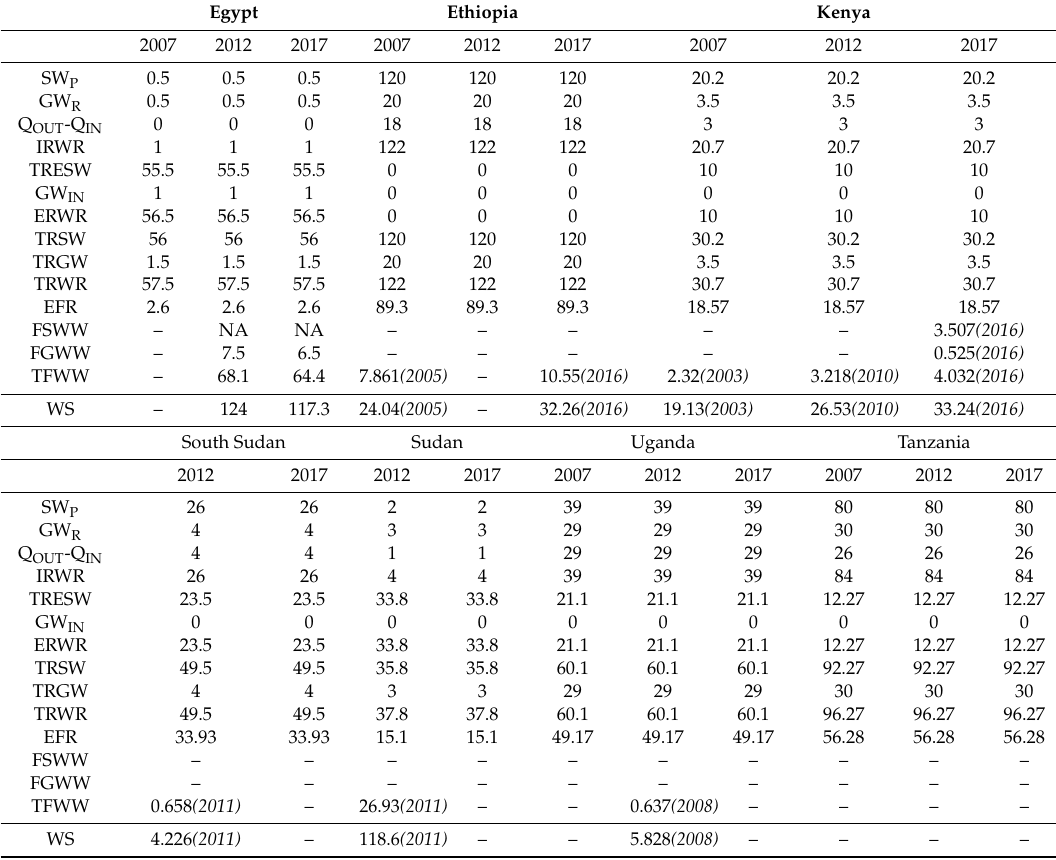
Table 2. The water stress and related parameters of countries in the Nile watershed.